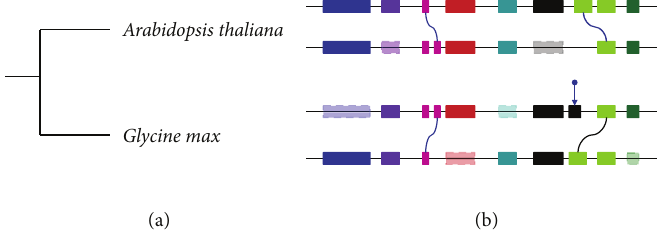
Figure1:(a)Phylogenetictreesfor Arabidopsisthaliana and Glycinemax .(b)Sketchmapofcollineargenesinblocks.Apairofhorizontallines which have the same color represent one collinear DNA fragment in one species. Horizontal lines with different colors represent collinear DNA fragment from different species in phylogenetics tree. Different genes denoted by rectangles have different colors, and the collinear homologous genes denoted by rectangles have the same colors. Rectangles surrounded by imaginary line represent the gene loss events. The blue curve shows the gene duplication, and the blue arrows indicate the gene insertion.